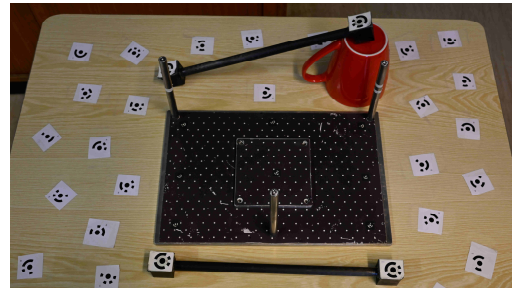
Figure 8: Measurement object consisting of ground plate and measurement panel.